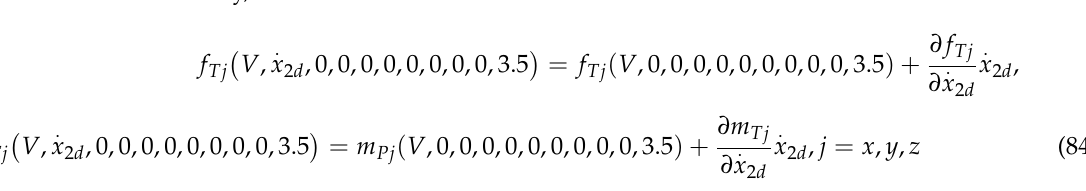
Figure 10. Influence of current velocity V on the power of turbine.